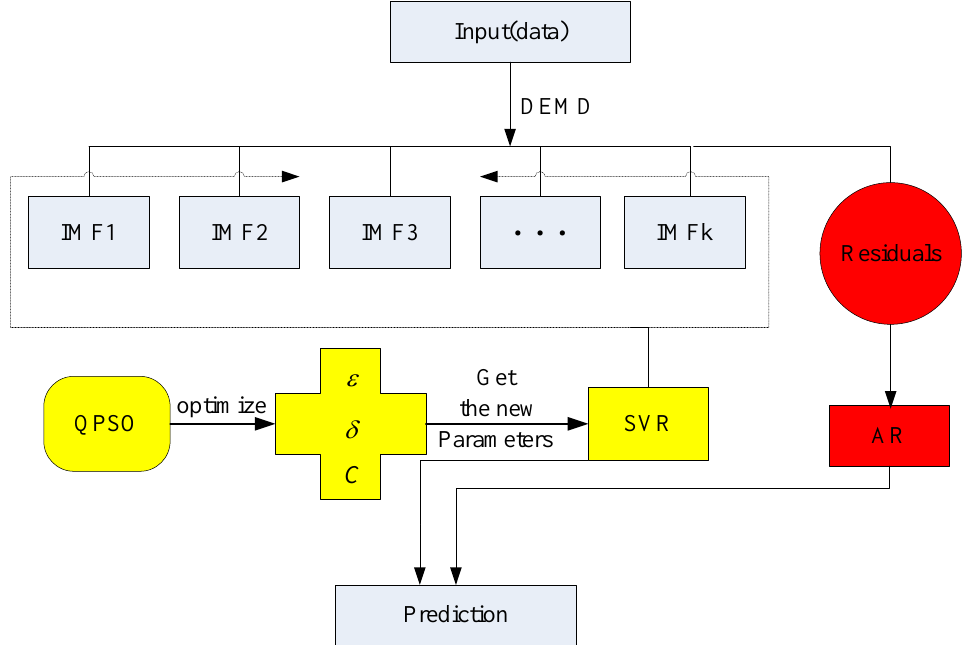
Figure 3. The full flowchart of the DEMD-QPSO-SVR-AR model flowchart.